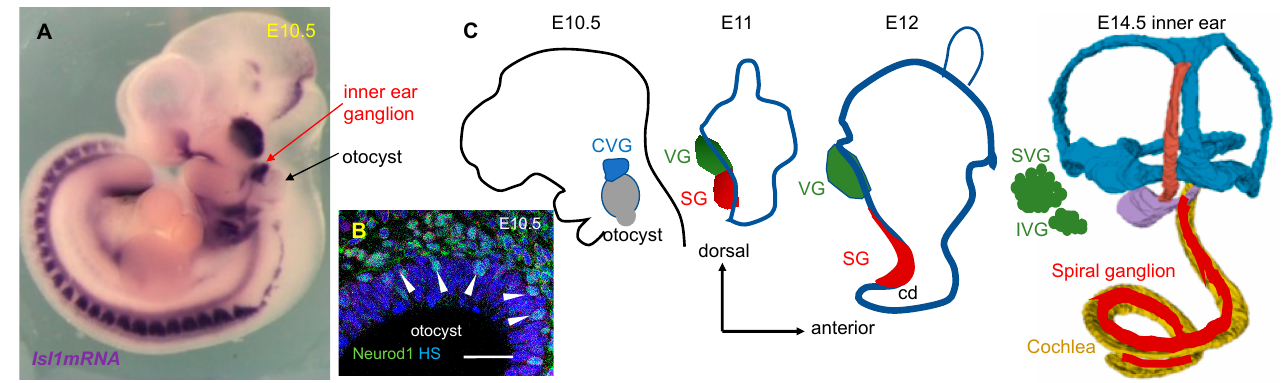
Figure 3. Morphogenesis of the inner ear ganglia. ( A ) Neurons forming cochleovestibular ganglion in the mouse embryo at E10.5 are visualized by the detection of Isl1 mRNA in situ hybridization. Image from Reference [41]. ( B ) NEUROD1 + delaminating neuroblasts detected in the proneurosensory epithelium of the otocyst. Confocal image with permission from Reference [39]. Scale bar, 100 µ m. ( C ) The stages of inner ear morphogenesis are shown schematically from the otocyst to the mature three-dimensional structure. In parallel, the neurons delaminate to form first a cochlear-vestibular ganglion (CVG), followed by the gradual separation of the vestibular (VG, green) and spiral (SG, red) ganglia, which eventually innervate the vestibular and auditory sensory epithelia. cd, cochlear duct; HS, Hoechst nuclear staining; SVG, superior vestibular ganglion; and IVG, inferior vestibular ganglion.